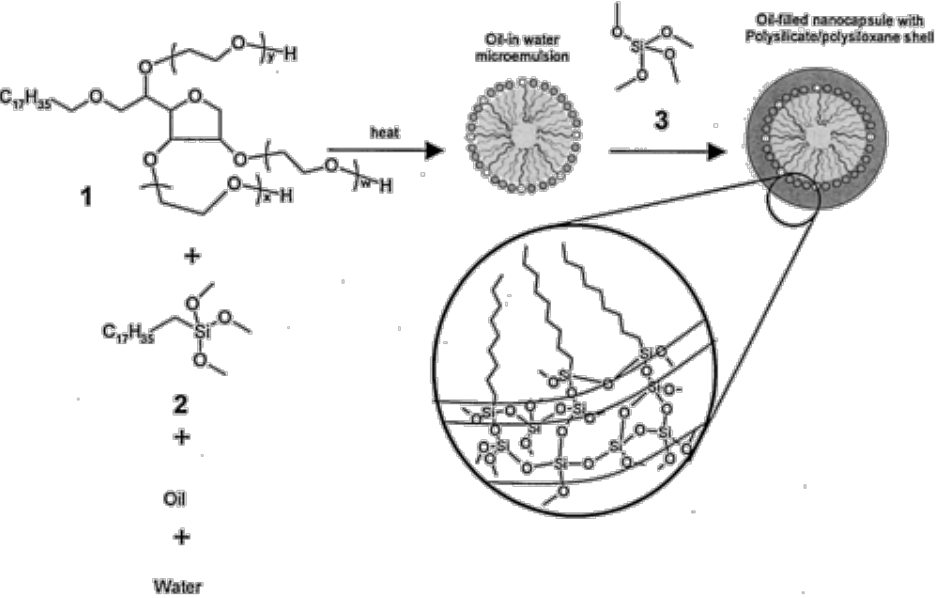
Figure 5. Formation of a mixed surfactant oil-in-water (O/W) microemulsion using Brij 97 ((1), filled circles, w + x + y = 10); and n -octadecyltrimethoxysilane ((2), open circles), followed by the formation of a stable shell through condensation of tetramethoxysiloxane (3) around the microemulsion droplet. The inset illustrates the polysiloxane/silicate network forming the shell. Reprinted from [31], © 2002 with permission from ACS Publications.